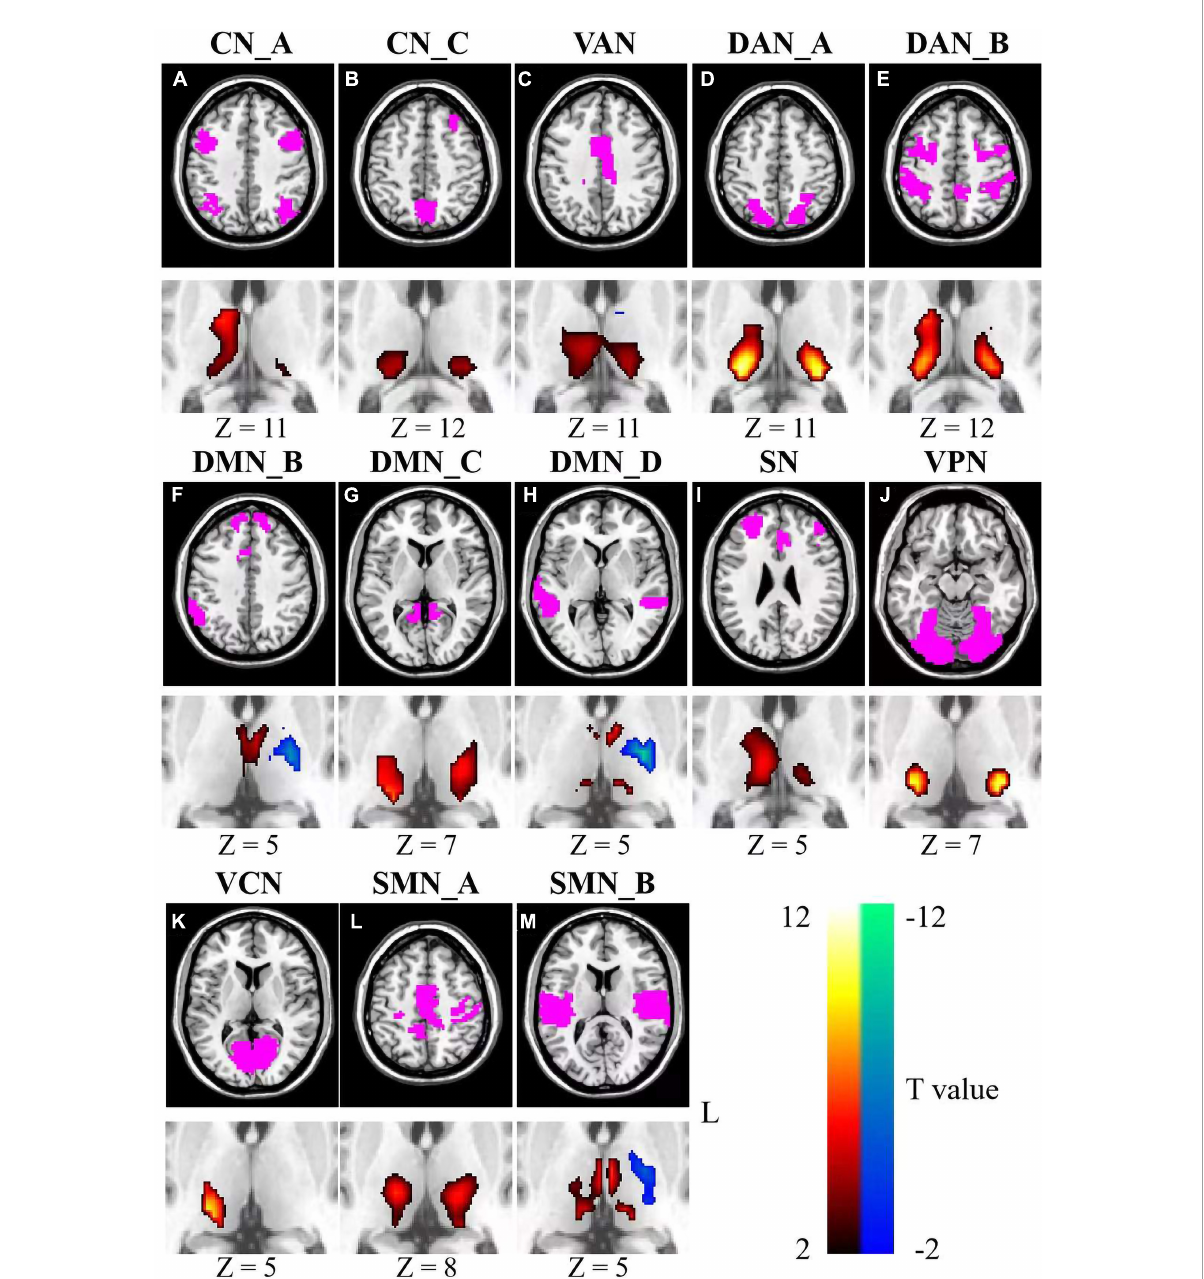
FIGURE3 Relationships between fluid intelligence and ISFCs between the thalamus and cortical networks (A–M) . Color bar signifies the T statistics (warm color, ISFCs increased significantly as fluid intelligence scores increased; cool color, ISFCs decreased significantly as fluid intelligence scores increased; FDR-corrected). L represents the left hemisphere. A minimum cluster size was 23 adjacent voxels in the thalamus. CN_A, control network A; CN_C, control network C; VAN, ventral attention network; DAN_A, dorsal attention network A; DAN_B, dorsal attention network